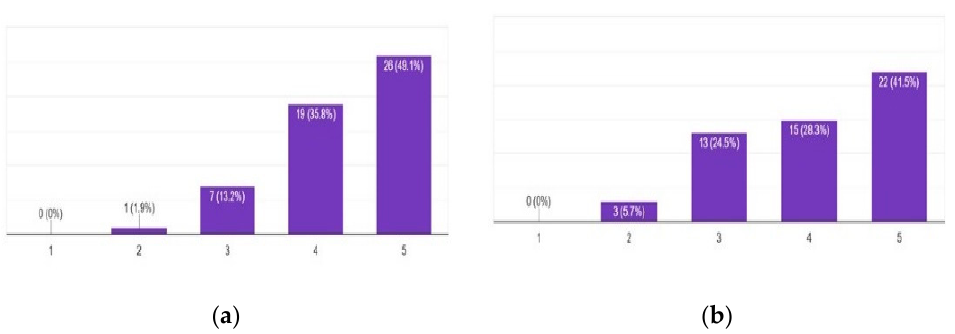
Figure 15. Participants’ opinion: ( a ) the application assists students to better understand hardware interconnection issues; ( b ) the application assists students to better understand software cooperation issues.